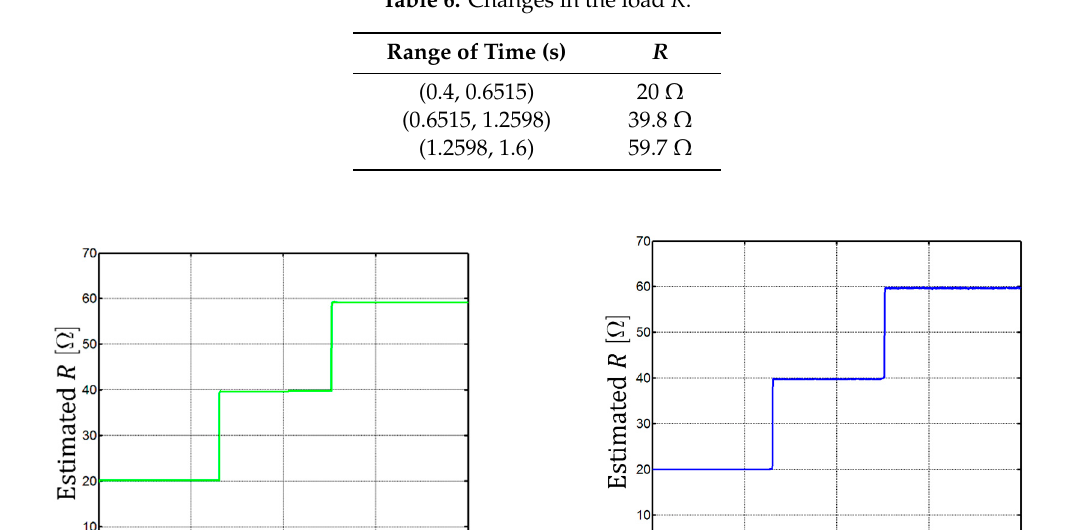
Table 6. Changes in the load